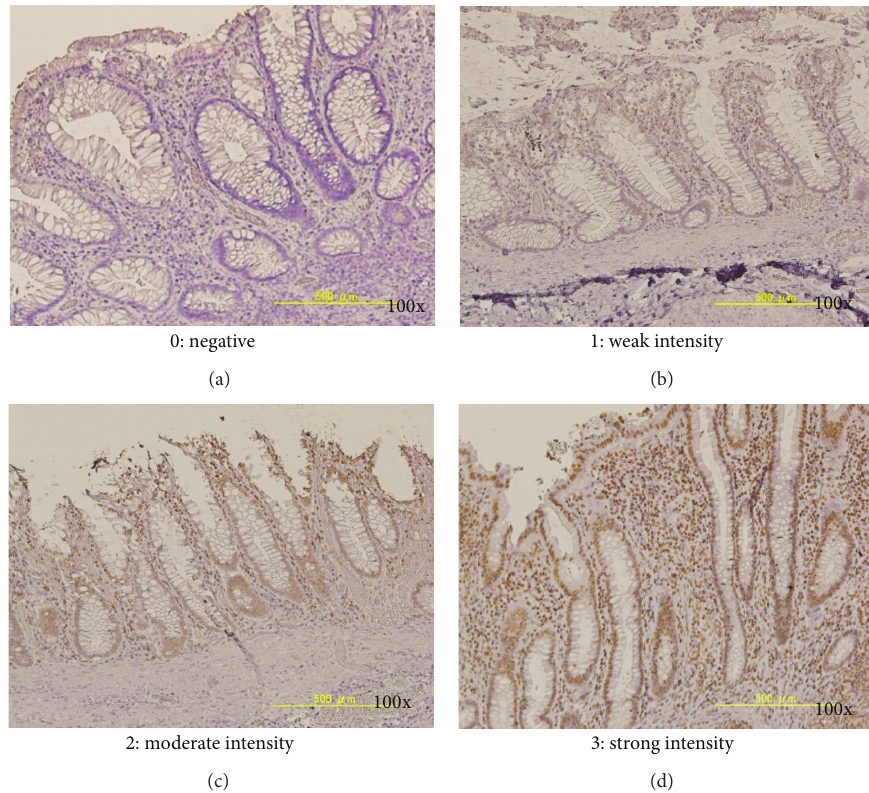
Figure 1: Immunohistochemical findings for CCL20 in the rectal mucosa. CCL20 expression was observed in the nucleus of epithelial cells, inflammatory cells, and lymphoid follicles. Different grades of CCL20 intensity in epithelial cells were evaluated as follows: grade 0 (negative, (a)), 44 specimens; grade 1 (weak, (b)), 37 specimens; grade 2 (moderate, (c)), 48 specimens, and grade 3 (severe, (d)), 12 specimens, respectively. Original magnification, 100x.